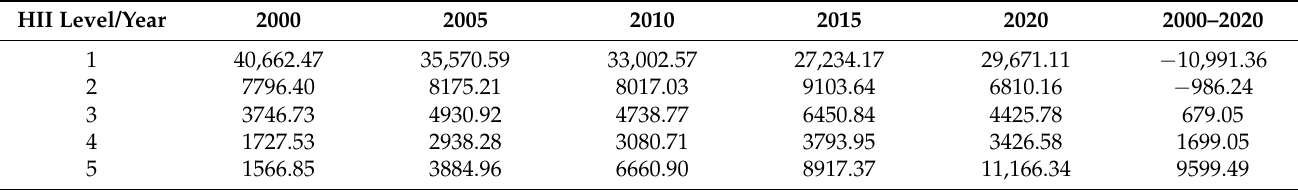
Table 6. GBA heat island area change of each intensity (km 2 ) from